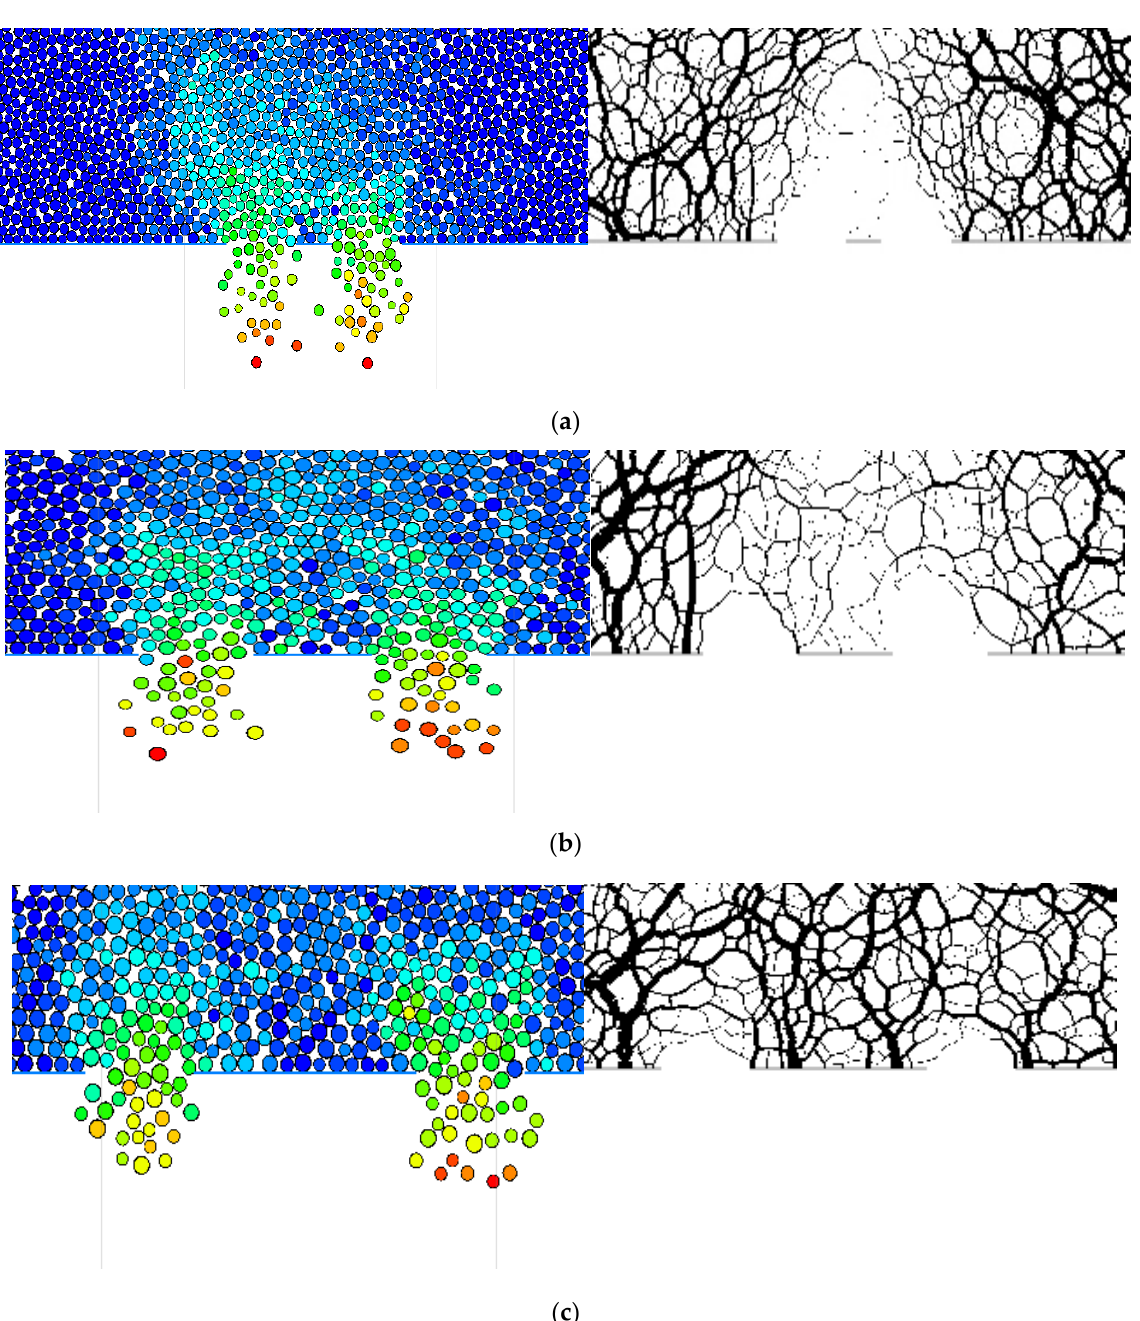
Figure 7. A displacement vector and contact force chain diagram of soil particles with different